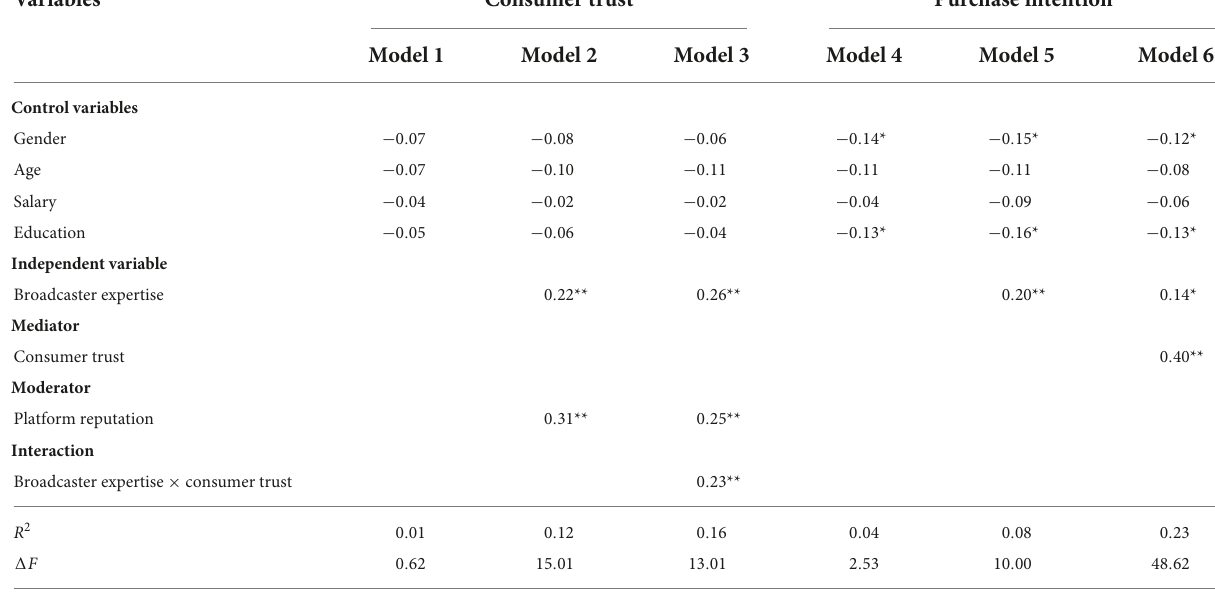
TABLE 3 Results of hierarchical multiple regression.